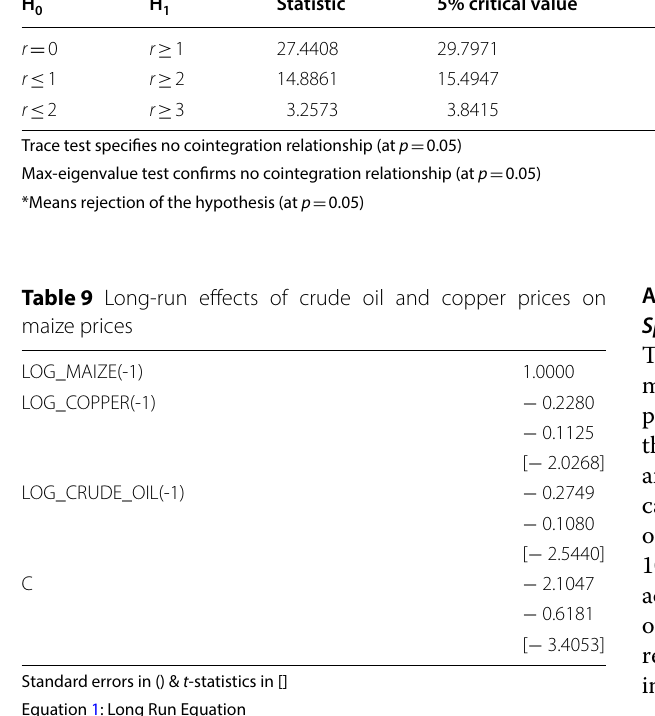
Table 8 Cointegration test results 2000 to 2021 data